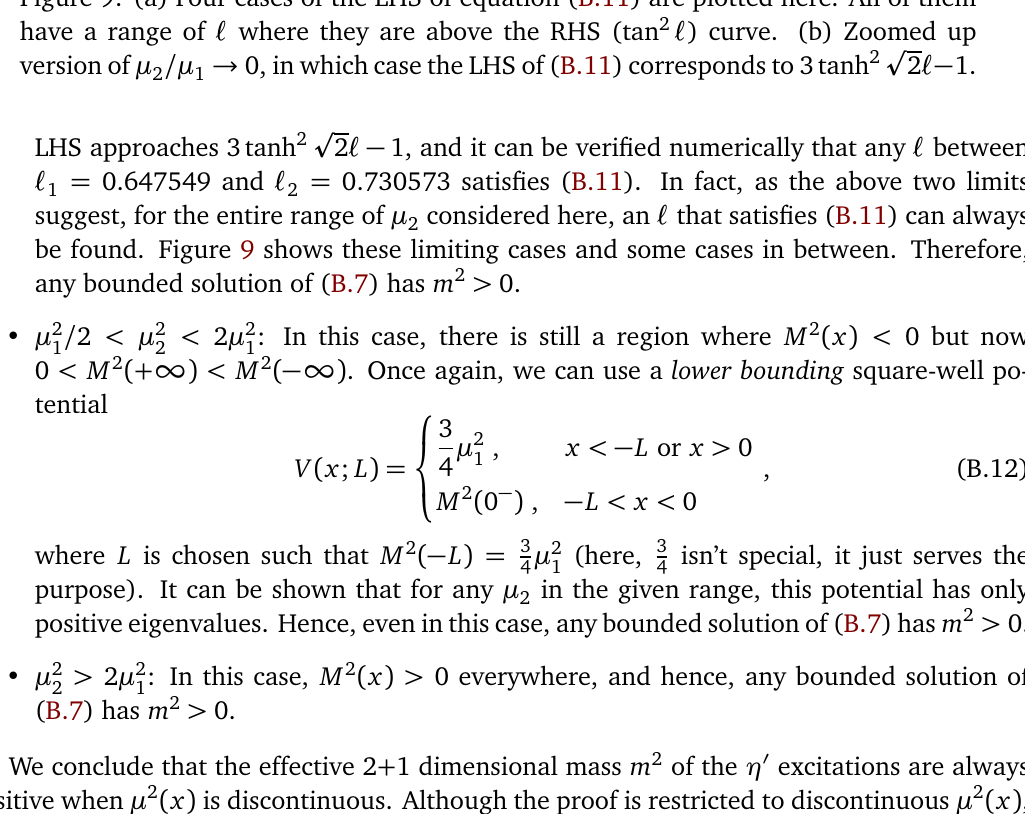
(cid:112) 2 (cid:96) − 1.